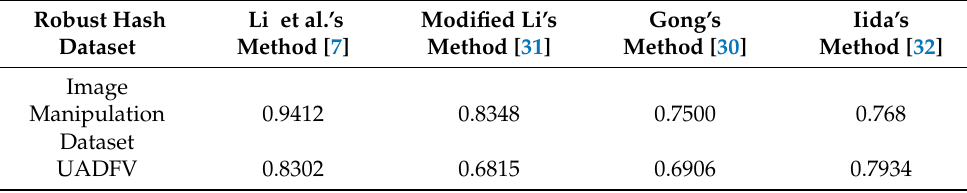
Figure 5. The selection of d . ( a ) Image Manipulation Dataset and UADFV; ( b ) CycleGAN and StarGAN. Table 2. Comparison of robust hashing methods (F-score).